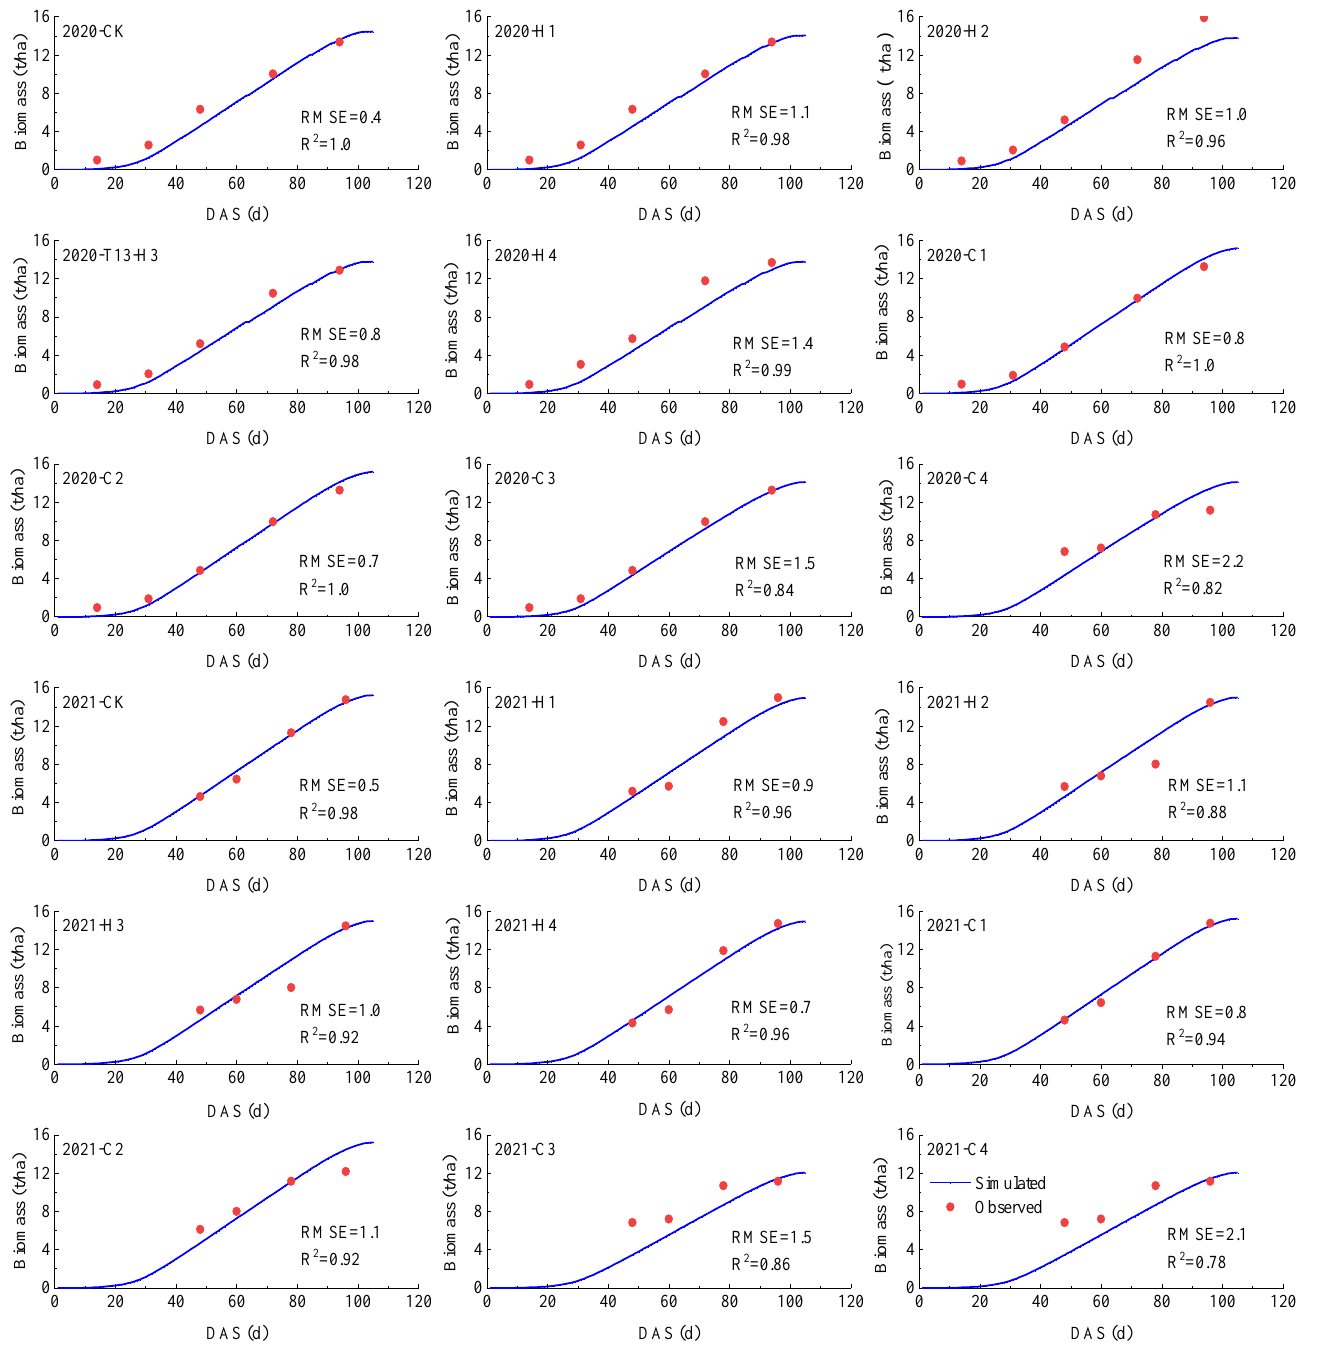
Figure 3. Simulated and observed biomass curves of maize under all treatments in 2020–2021. DAS is the days after sowing.